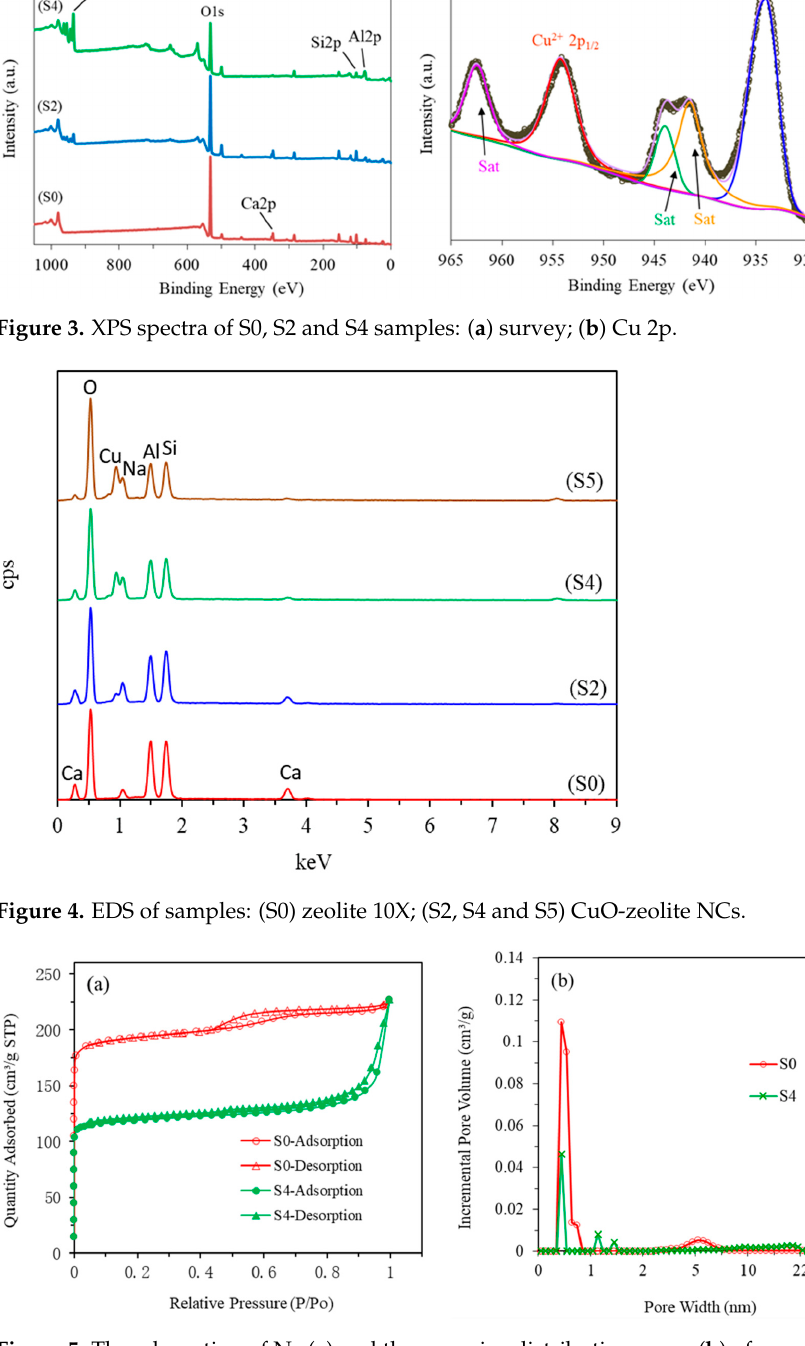
Figure 3. XPS spectra of S0, S2 and S4 samples: ( a ) survey; ( b ) Cu 2p.